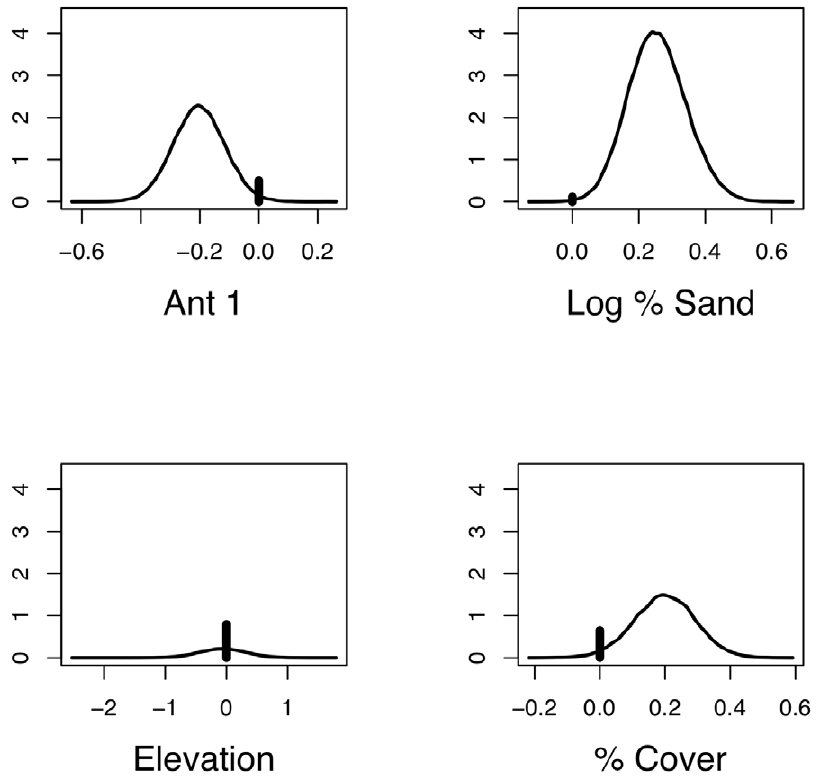
Figure 1. Marginal posterior density estimates for the top 4 PIP regression coefficients in the lizard abundance analysis. Included are coefficients are: Ant 1 ( b 1 ), log % sand ( b 3 ), Elevation ( b 4 ), and % cover ( b 6 ). Vertical bars represent p ( b j ~ 0) and the density curve is a kernel estimate